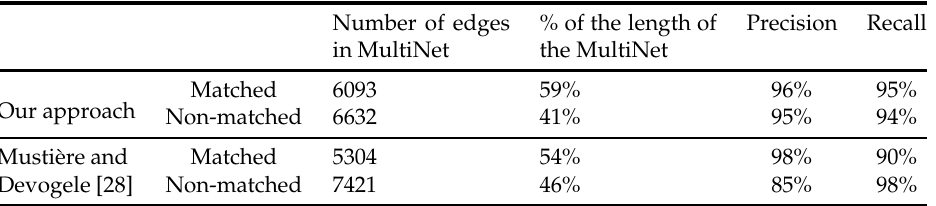
Table 2: Qualitative evaluation of results for road